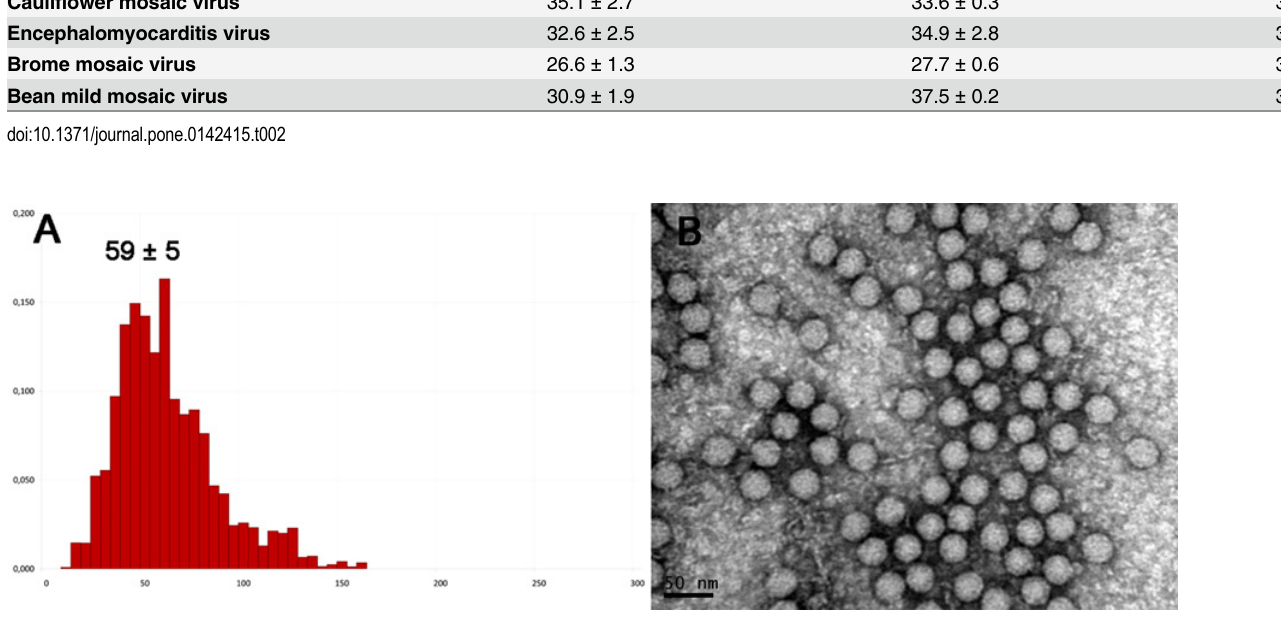
Table 2. Comparative characteristics of the sizes of icosahedral virions using TEM and techniques in liquid (DLS and NTA), considering the contri- bution of EDL.